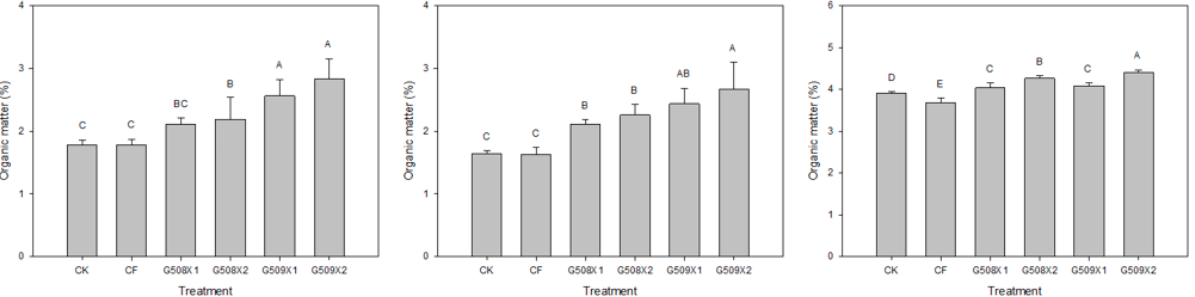
Figure 2. The organic matter content of the soil after the field experiment under different treatments: cabbage ( left ), Chinese cabbage ( middle ), and water spinach ( right ). The different letters indicate the significance among the treatments obtained through one-way ANOVA analysis (Duncan test, p < 0.05, n = 4). The codes have the same meanings as those in Figure 1.